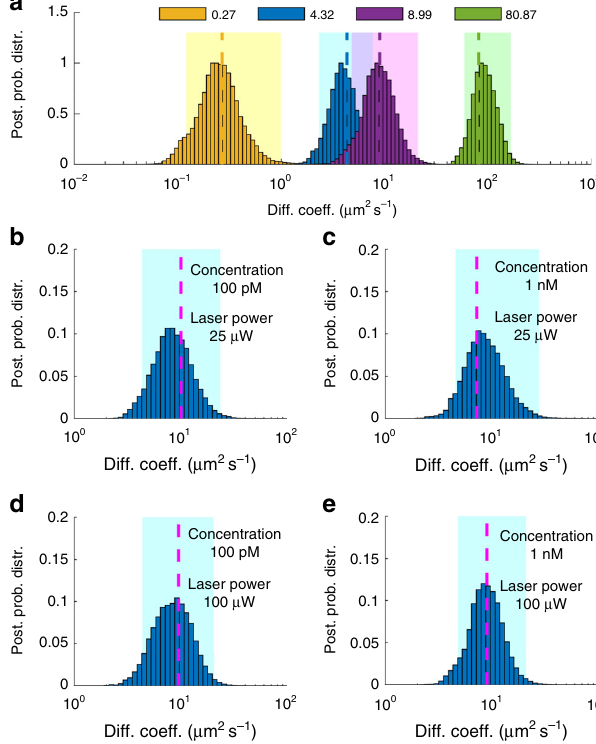
Fig. 6 Estimating diffusion coef fi cients of free streptavidin. a Posterior probability distributions of diffusion coef fi cients of free streptavidin labeled by Cy3 in different concentrations of glycerol/water mixture. The legend labels the posteriors according to FCS estimates of long time traces. For clarity, posteriors are normalized to maximum 1 and the horizontal axis is shown in logarithmic scale. Also, the 95% con fi dence intervals are shown by highlighted regions. Posteriors are obtained from the analyses of time traces acquired at 100 μ s for total periods of 100 ms. Different diffusion coef fi cients are obtained by varying the amount of glycerol from 94 to 0% in the glycerol/water mixture. b – e Posterior probability distributions over the diffusion coef fi cients of traces generated by different laser powers (25 and 100 μ W, respectively) with different concentrations of Cy3 (100 p M and 1 n M , respectively) in a glycerol/water mixture of 94% glycerol. For the sake of comparison, FCS estimates, shown by dashed lines, are obtained by traces each 6 min long